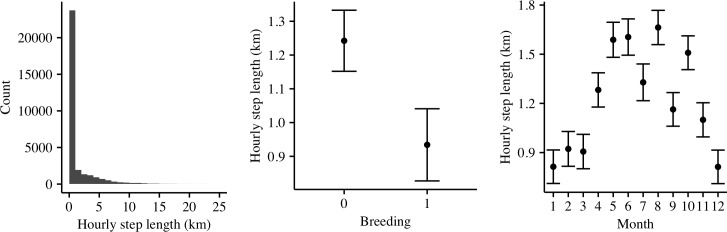
Frequency of step lengths in 1 km (0–10 km) and 15 km (10–100 km) intervals (left), and fixed effects plots from a generalised linear mixed model investigating step lengths between the breeding and non-breeding period (centre) and between months to assess seasonality (right).